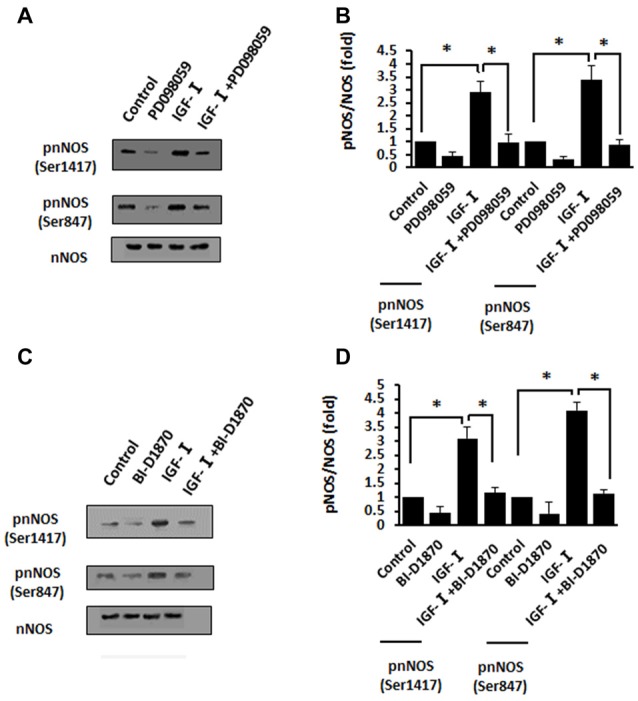
IGF-I-induced phosphorylation of nNOS depends on ERK1/2/RSK signaling. (A,B) IB analysis of lysates of PHNs with or without IGF-I treatment in the absence or presence of PD098059 using anti-pnNOS Ser1417/Ser847 and anti-nNOS antibodies and subsequent densitometry. (C,D) IB analysis of lysates of PHNs with or without IGF-I treatment in the absence or presence of BI-D1870 using anti-pnNOS Ser1417/Ser847 and anti-nNOS antibodies and subsequent densitometry. Data are shown as mean ± SD. *P < 0.05.